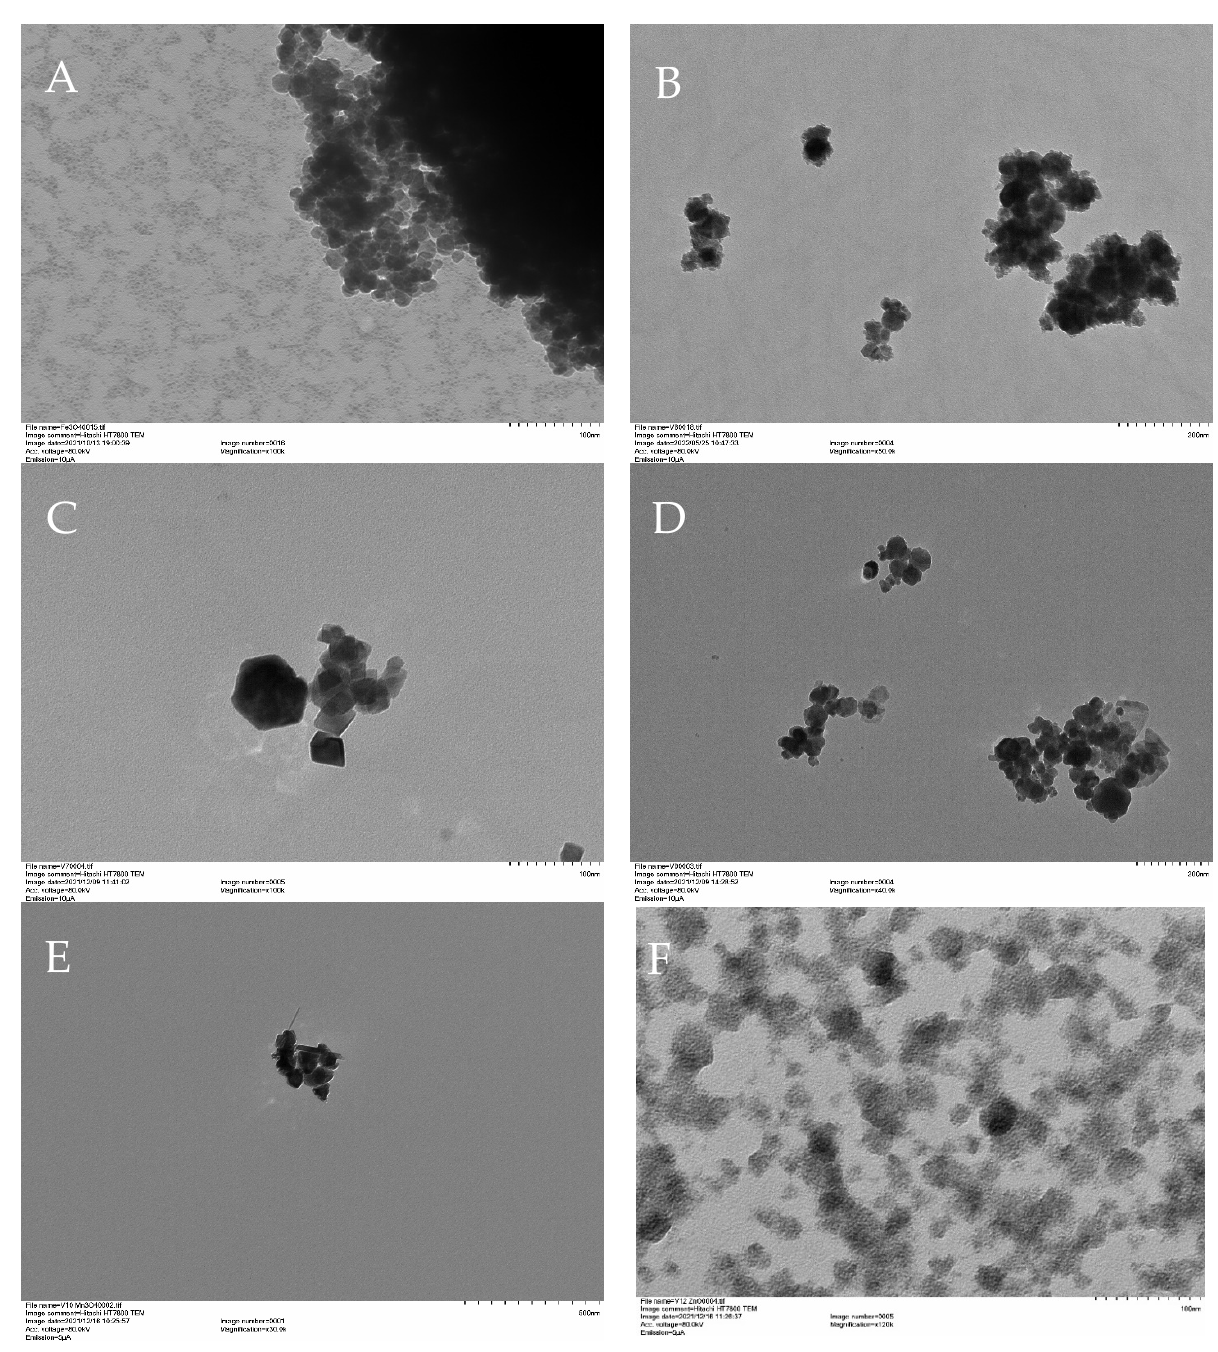
Figure 3. TEM Images of ( A ) Fe 3 O 4 , ( B ) MnFe 2 O 4 , ( C ) ZnFe 2 O 4 , ( D ) Zn 0.5 Mn 0.5 Fe 2 O 4 , ( E ) Mn 3 O 4 , and ( F ) ZnO.